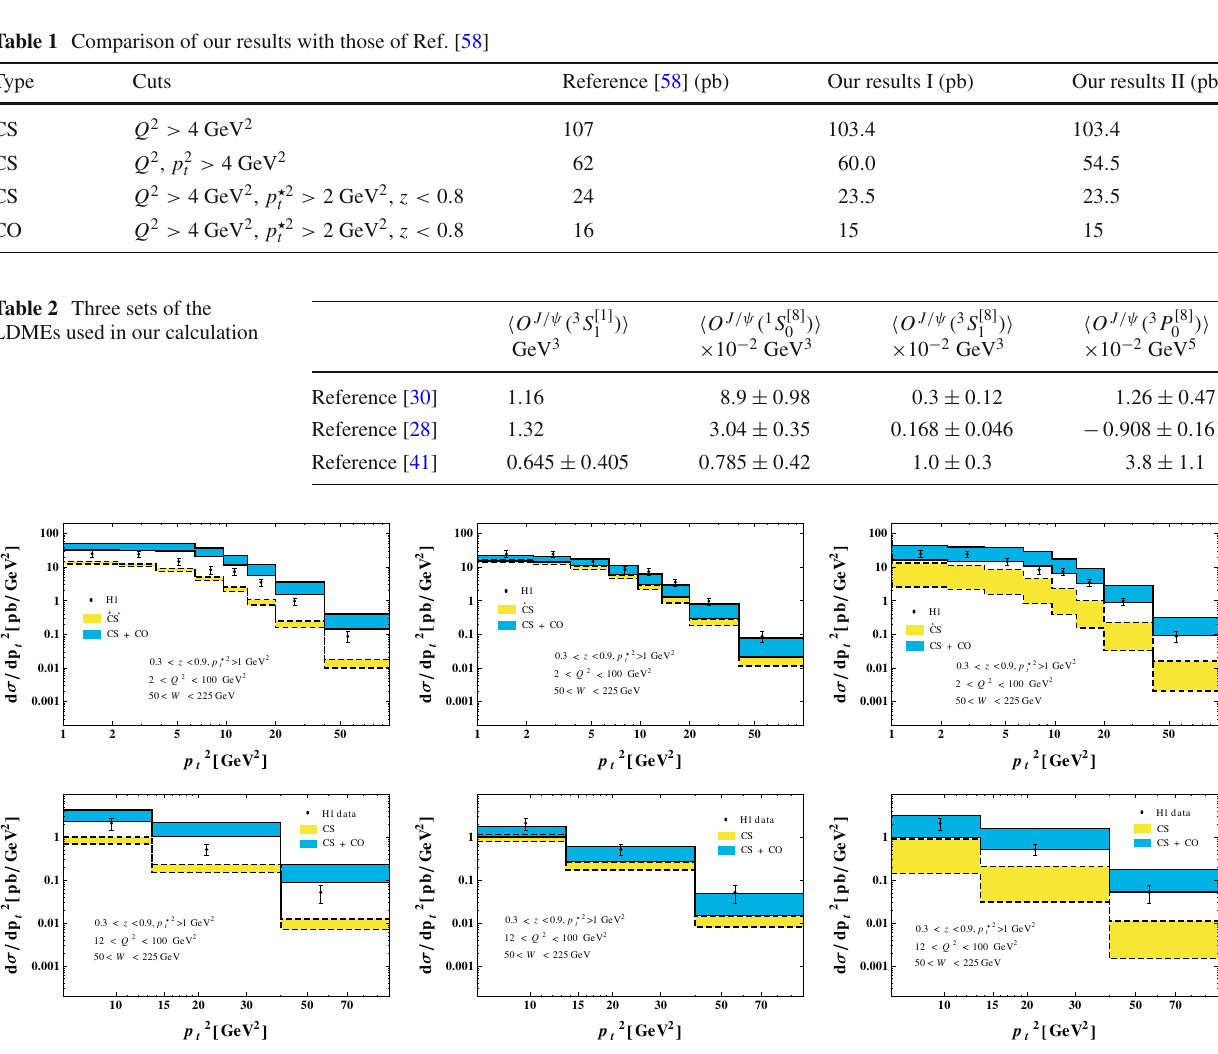
Fig. 2 The differential cross sections for the J /ψ production in DIS with respect to p 2 t . The experimental data are taken from Ref. [49]. The l.h.s., middle, and r.h.s. plots correspond to the LDMEs taken in Refs. [28,30,41],